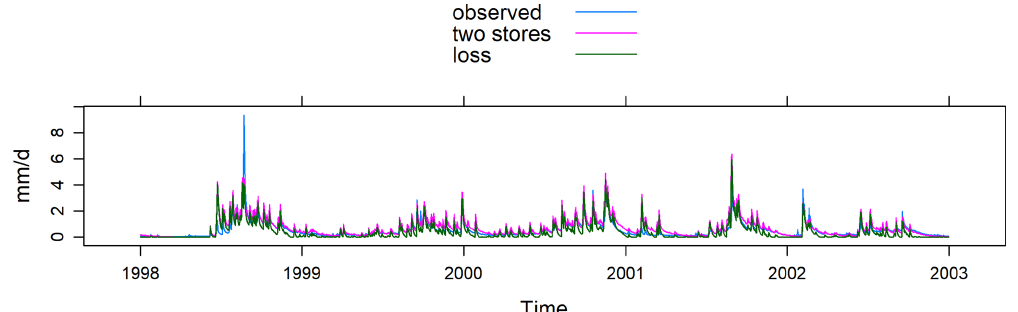
Figure A4. Example plots of simulation results from two model configurations enabled by the hydromad package. This example was generated by using one of the data sets included in the package and simulations with the IHACRES-CMD model. This chart can be visualised with a log